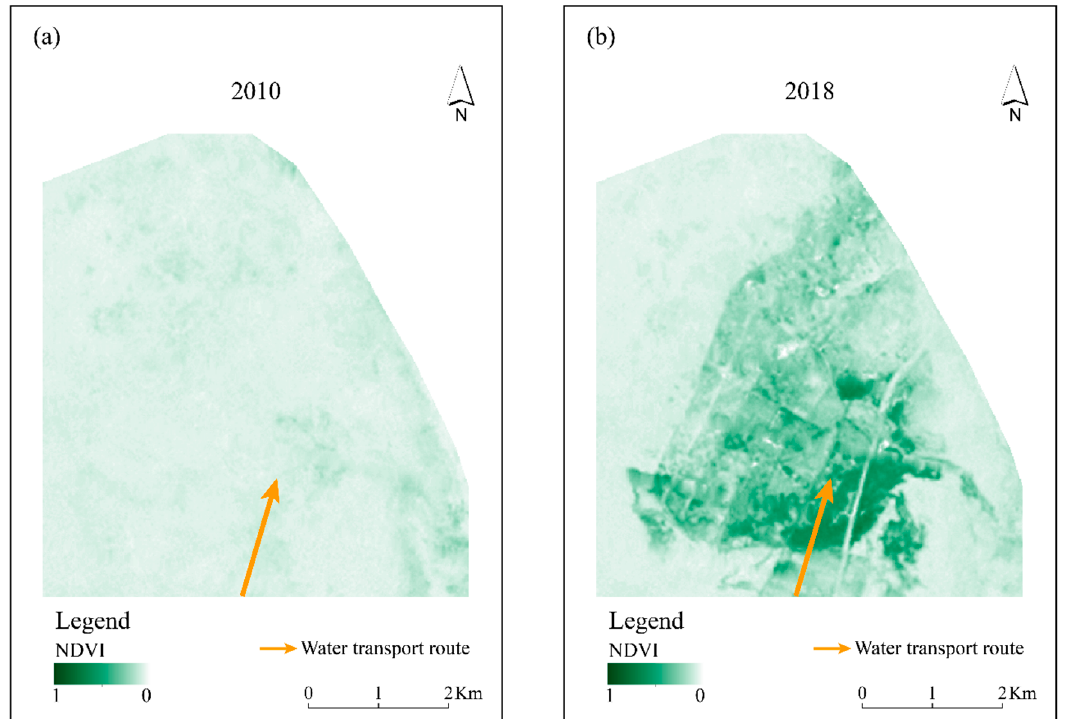
Figure 6. Panel ( a ): variation in the Normalized Vegetation Difference Index (NDVI) (scale from 0 to 1) of Qingtu Lake in July 2010. Panel ( b ): variation in the NDVI (scale from 0 to 1) of Qingtu Lake in July 2018.